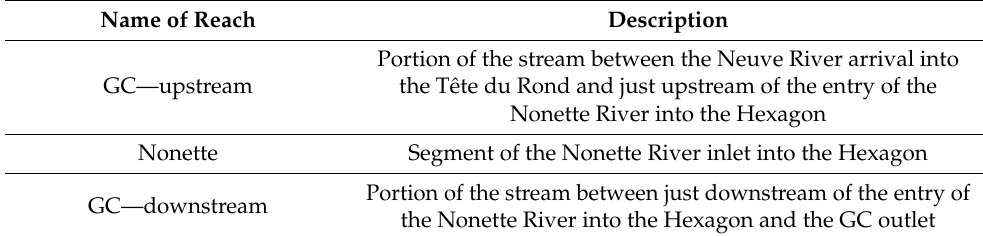
Table 8. Description of the three hydraulic system segments